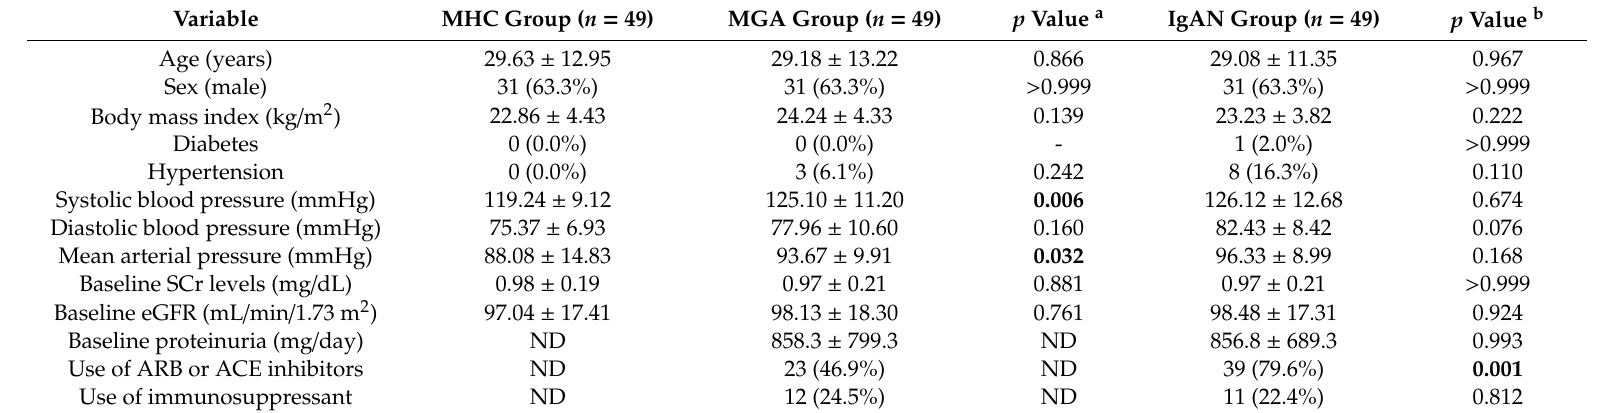
Table 1. Baseline characteristics of the MGA, MHC, and IgAN groups in the retrospective study